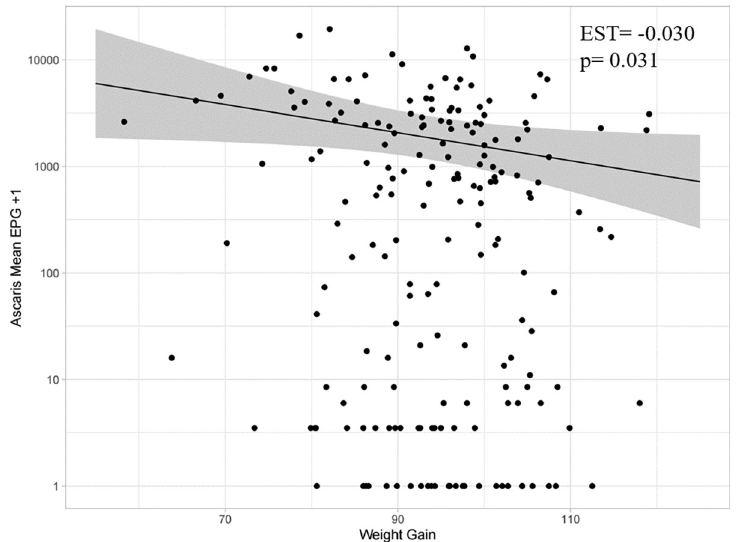
Fig 4. The relationship between Ascaris suum mean EPG (log scale) and weight gain (week 0–14) estimated using a generalised additive model (GAM) (n = 195). The estimate is shown by solid black line and 95% CI are shown in grey shading. Individual data points have been overlaid for reference (black dots), with a constant of 1 added before log transformation for the purposes of visualization only. Inset are the estimate (EST) and p-value generated using a generalised linear mixed model (GLMM) assuming that the relationship is